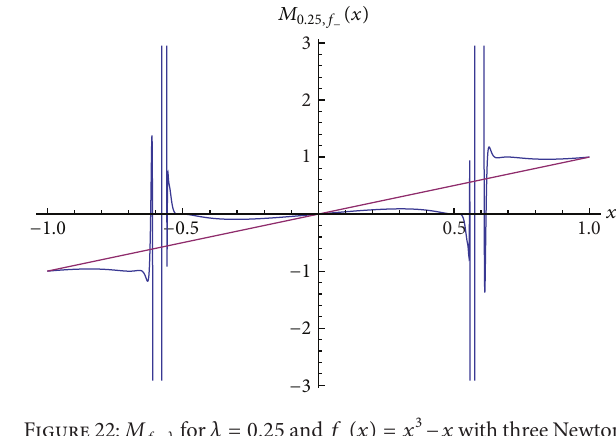
Figure 22: 𝑀 𝑓 for 𝜆 = 0.25 and 𝑓 − (𝑥) = 𝑥 3 −𝑥 with three Newton − ,𝜆 steps.